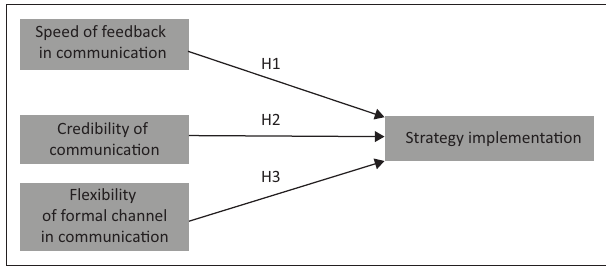
FIGURE 4: Final hypothesis